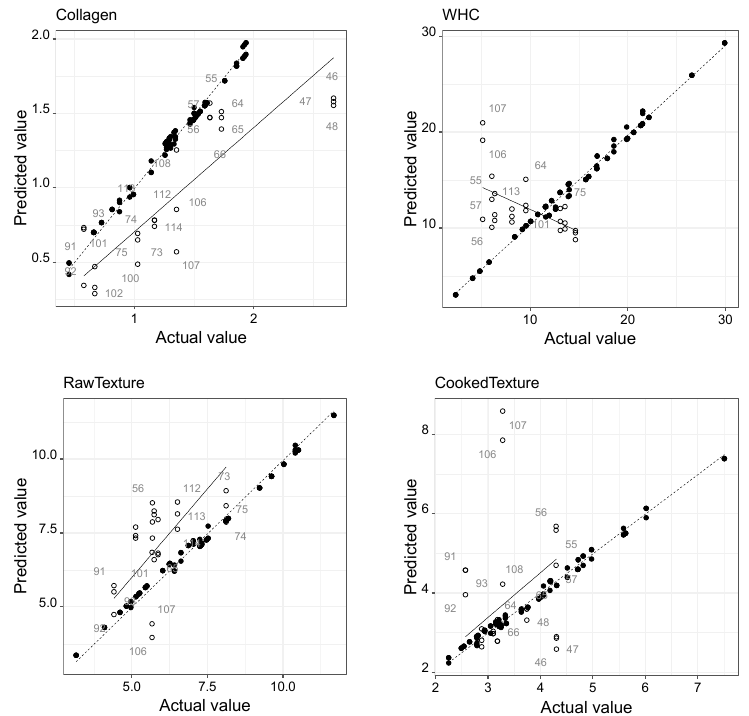
Figure 4. Predictive performance for all the best SVMR-Poly models obtained.